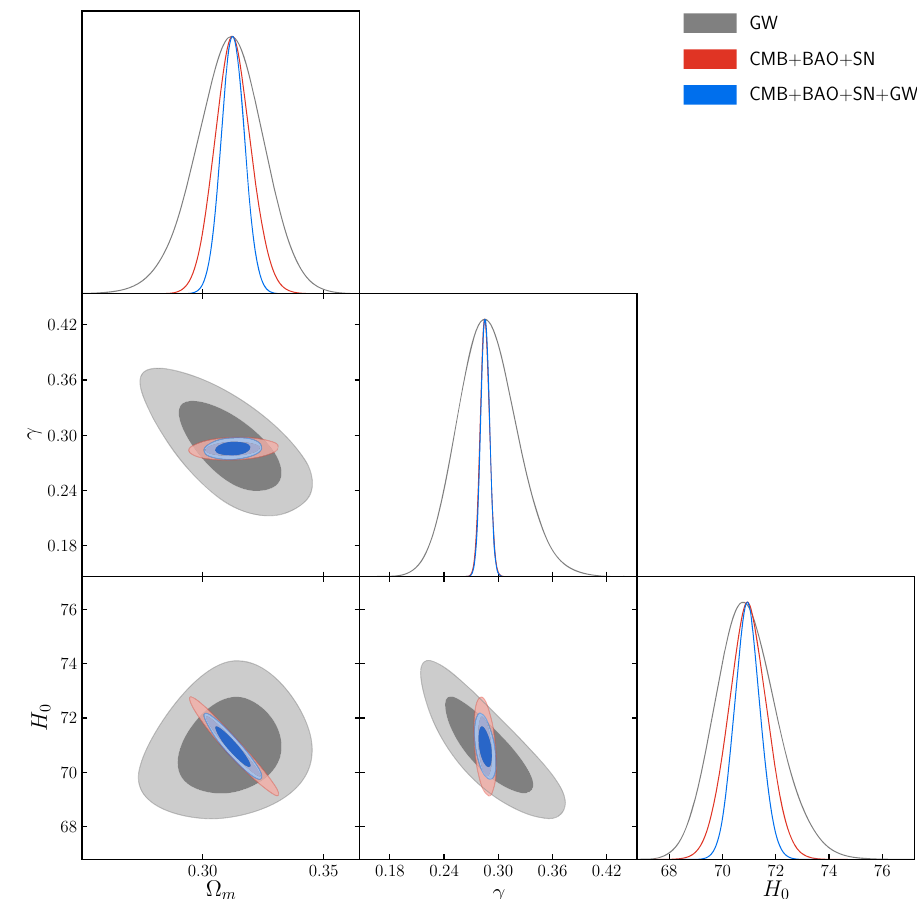
Fig. 4 Observational constraints (68.3% and 95.4% confidence level) on the RDE model by using the GW, CMB + BAO + SN, and CMB + BAO +